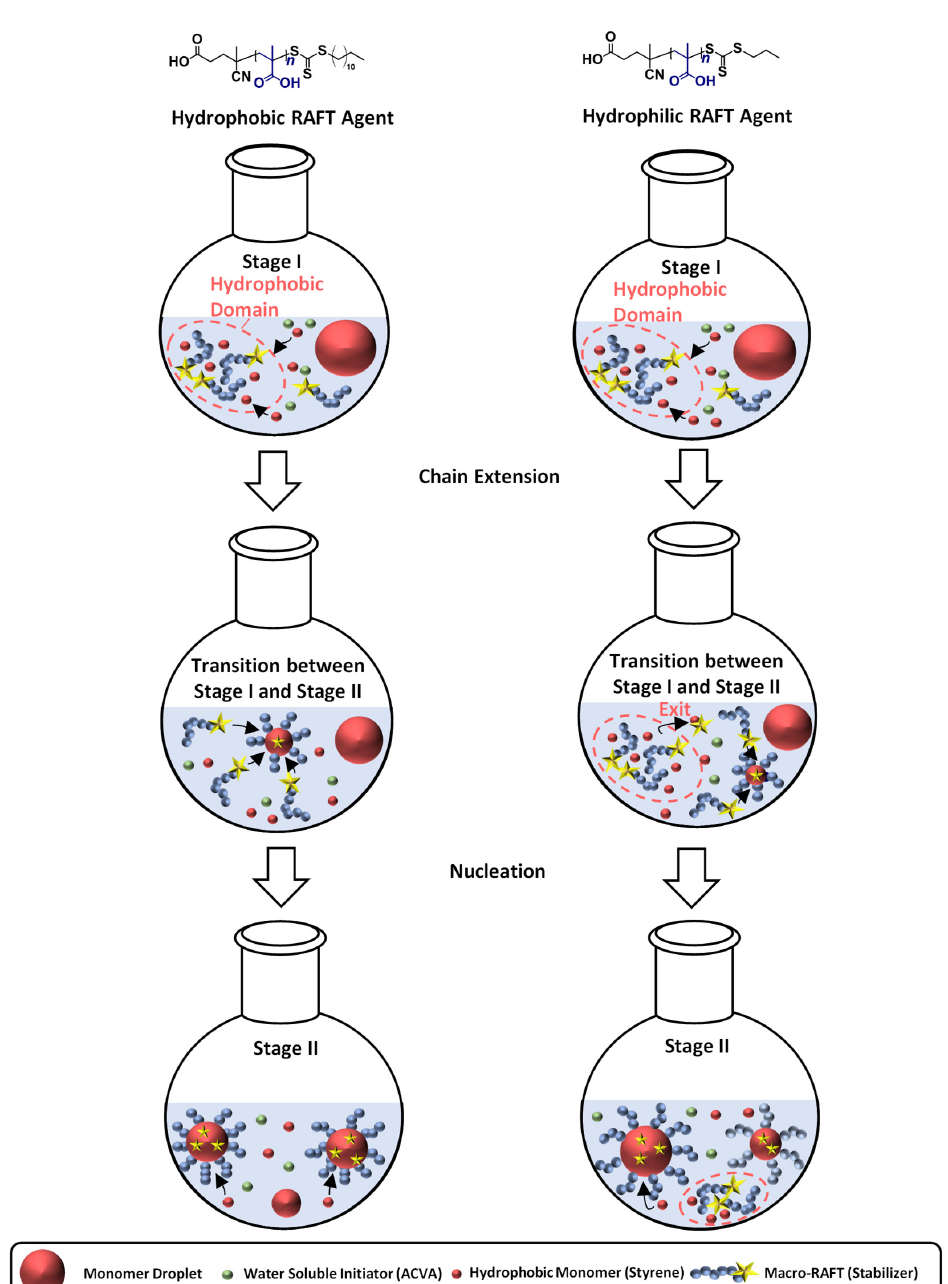
Figure 8. Illustration of the particle formation during an emulsion polymerization for a hydrophilic and hydrophobic RAFT agent as stabilizer with the three characteristics steps. Stage I shows the formation of micellar particles, Stage II the polymerization within the micelles and the transition state between both stages. The blue chains represent the stabilizing chain, the red chain the hydrophobic chain, the green circles label the initiator, the yellow star represents the active RAFT group, and the big red circles represent monomer swollen particles.